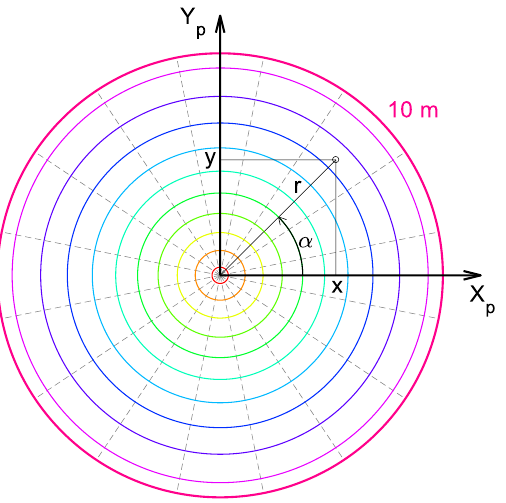
Figure 10. Regions defined by the fuzzy membership